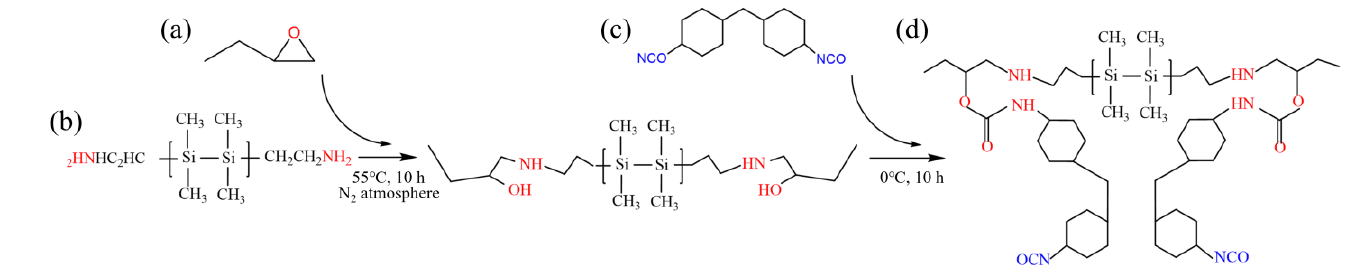
Figure 1. Synthesis of SPU, ( a ) 1,2-epoxybutane; ( b ) amino silicone oil; ( c ) HMDI; ( d ) SPU .